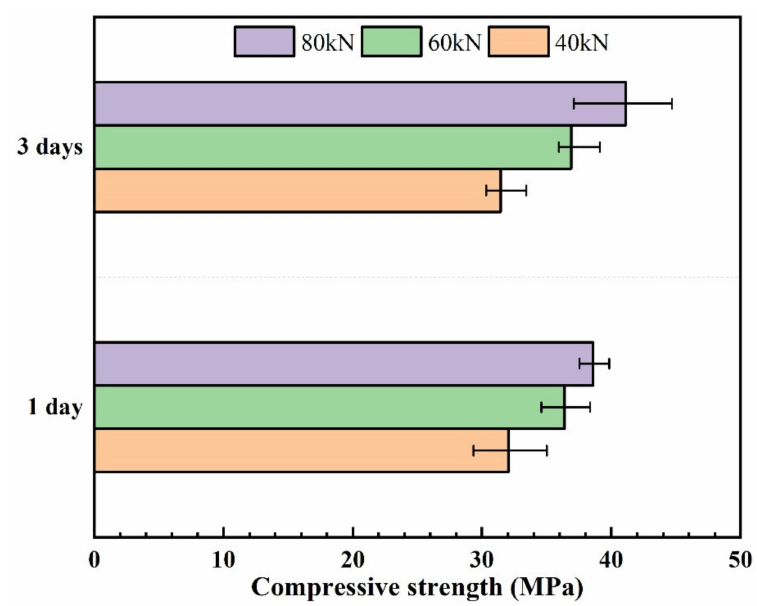
Figure 3. Compressive strength of FA60SS40 at different molding